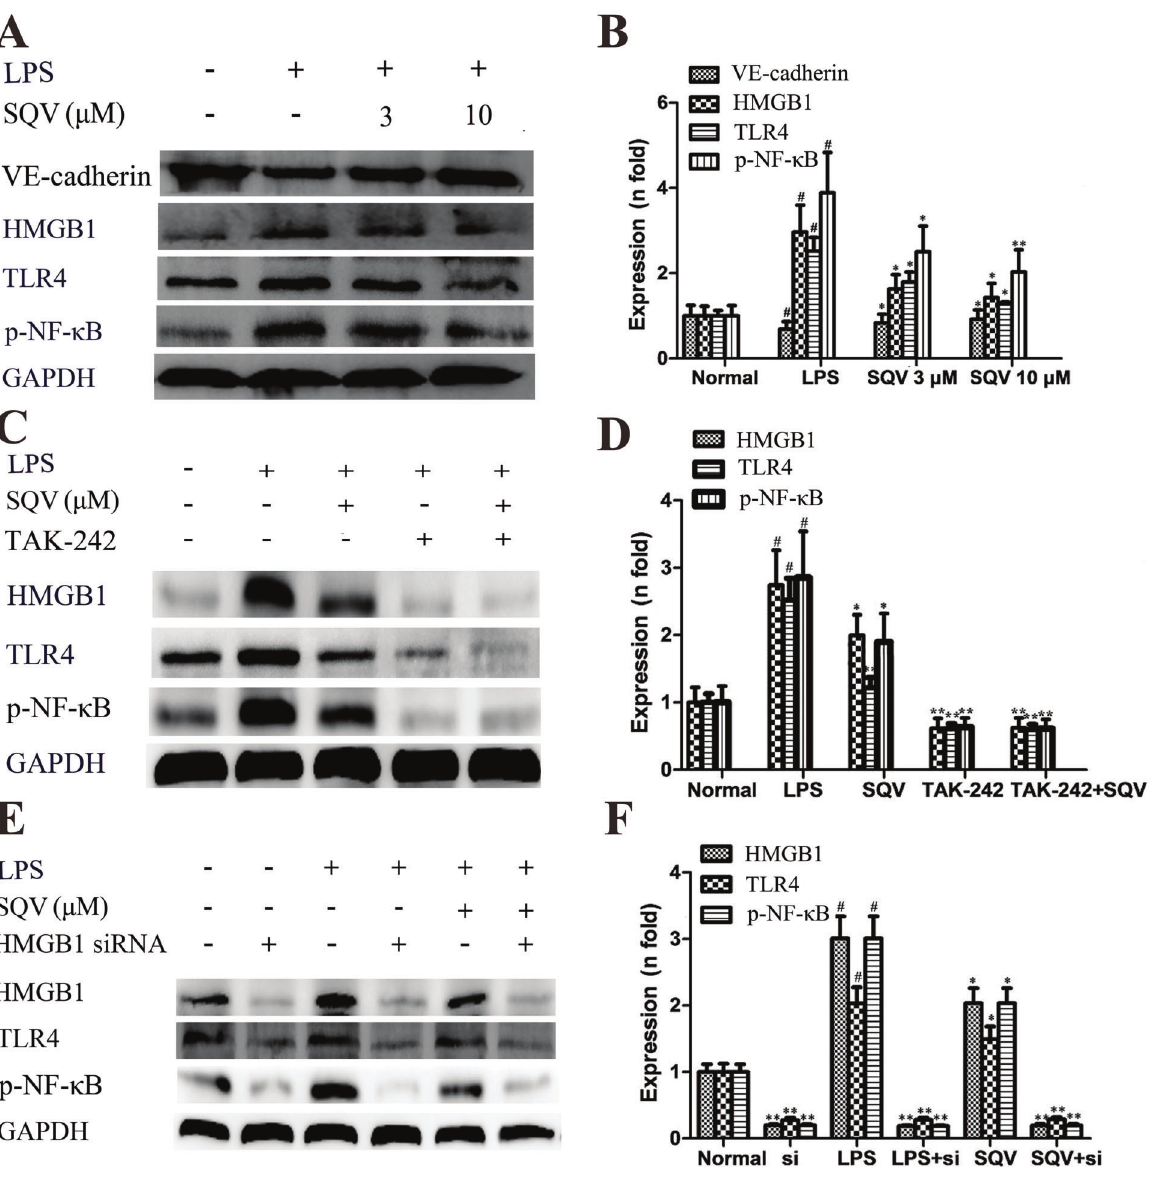
Figure 1. Effects of saquinavir (SQV) on high mobility group box 1 (HMGB1), toll-like receptor 4 (TLR4), and phospho-NF- k B (p-NF- k B) intensity in lipopolysaccharide (LPS)-prompted HPMECs by western blotting. A and B : human pulmonary microvascular endothelial cells (HPMECs) were incubated with or without LPS for 24 h. C and D : HPMECs were incubated with LPS with or without the TLR4 inhibitor (TAK-242) for 24 h. E and F : HPMECs were incubated with LPS with or without HMGB1 siRNA for 24 h. Data are reported as % above normal and means ± SD (n=5). # P o 0.01 vs the normal group; *P o 0.05, **P o 0.01 vs the LPS group (ANOVA with Dunnett ’ s